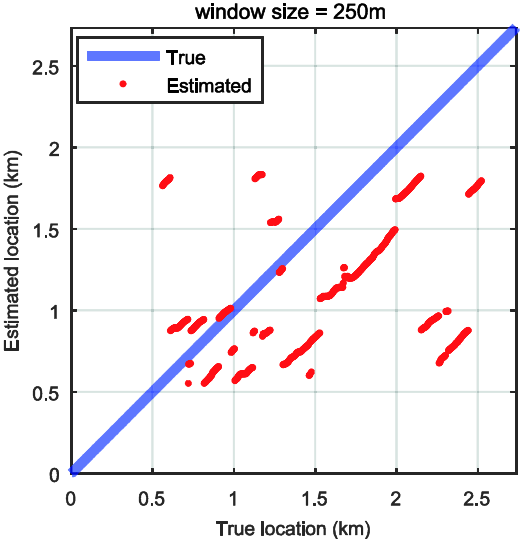
Figure 20. Localization result without road profile estimation (window size = 250 m).